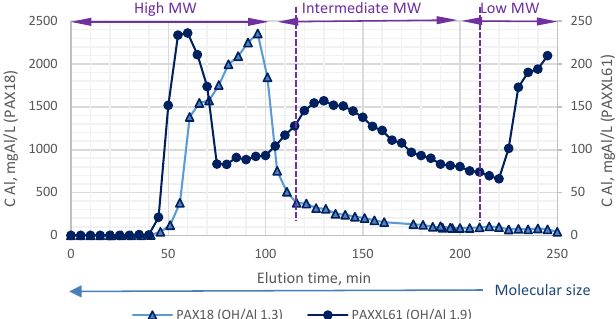
Figure 12. Size exclusion chromatograms of collected prepolymerized aluminium chloride (PACl) fractions.